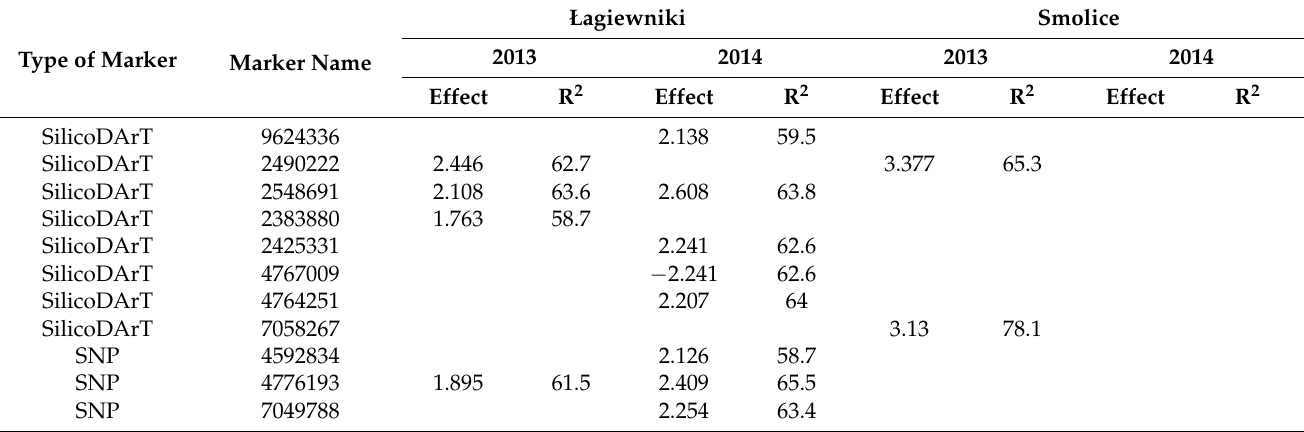
Table 3. Molecular markers significantly (LOD > 3.0) associated with the heterosis effect of core length (LCO).